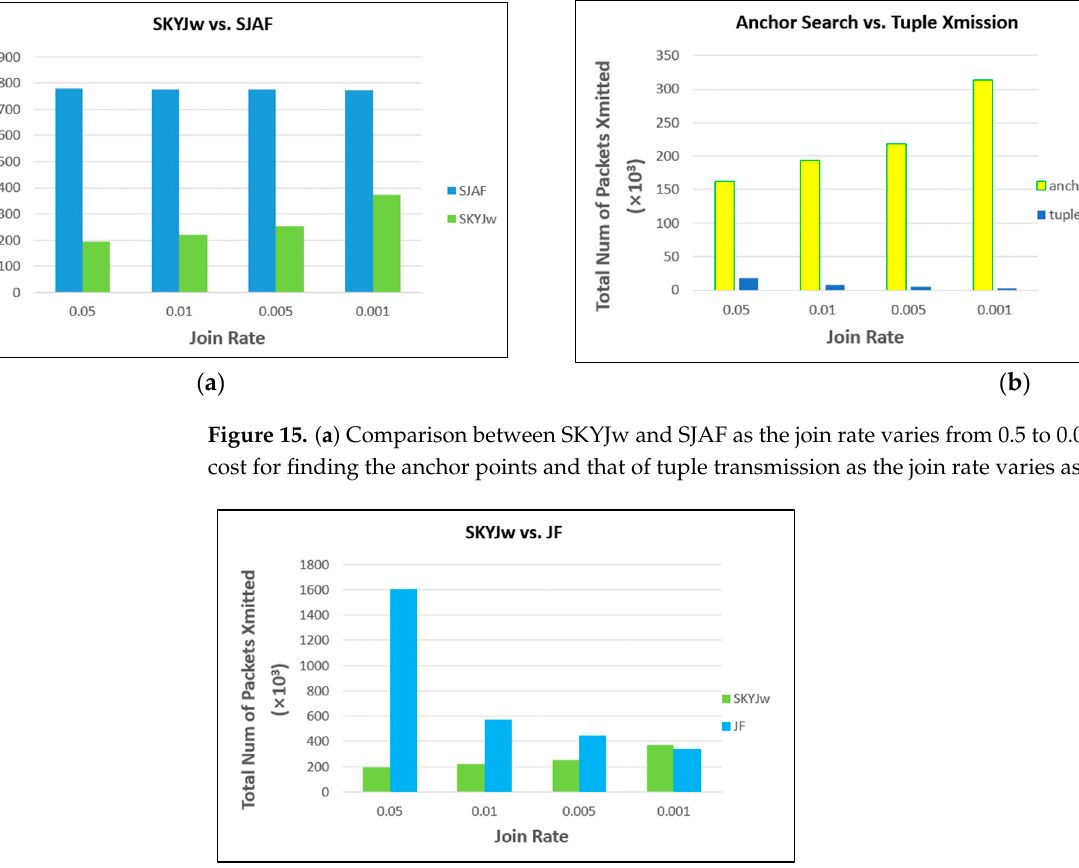
Figure 16. Comparison between SKYJw and JF for very low join rates.